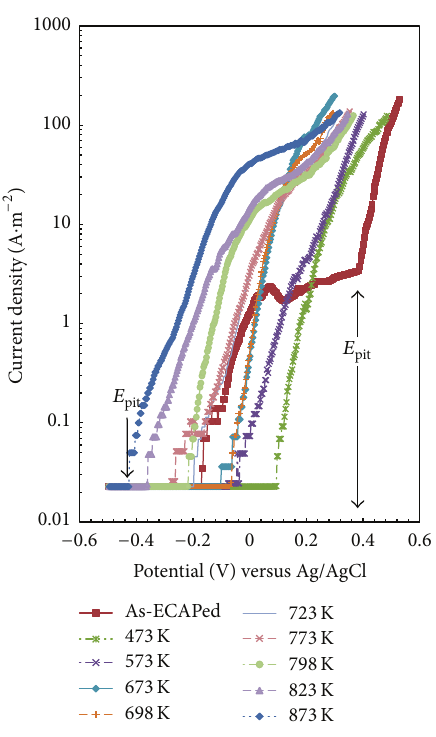
Figure 10: Dynamic anodic polarization curves in 1000mol ⋅ m −3 NaCl